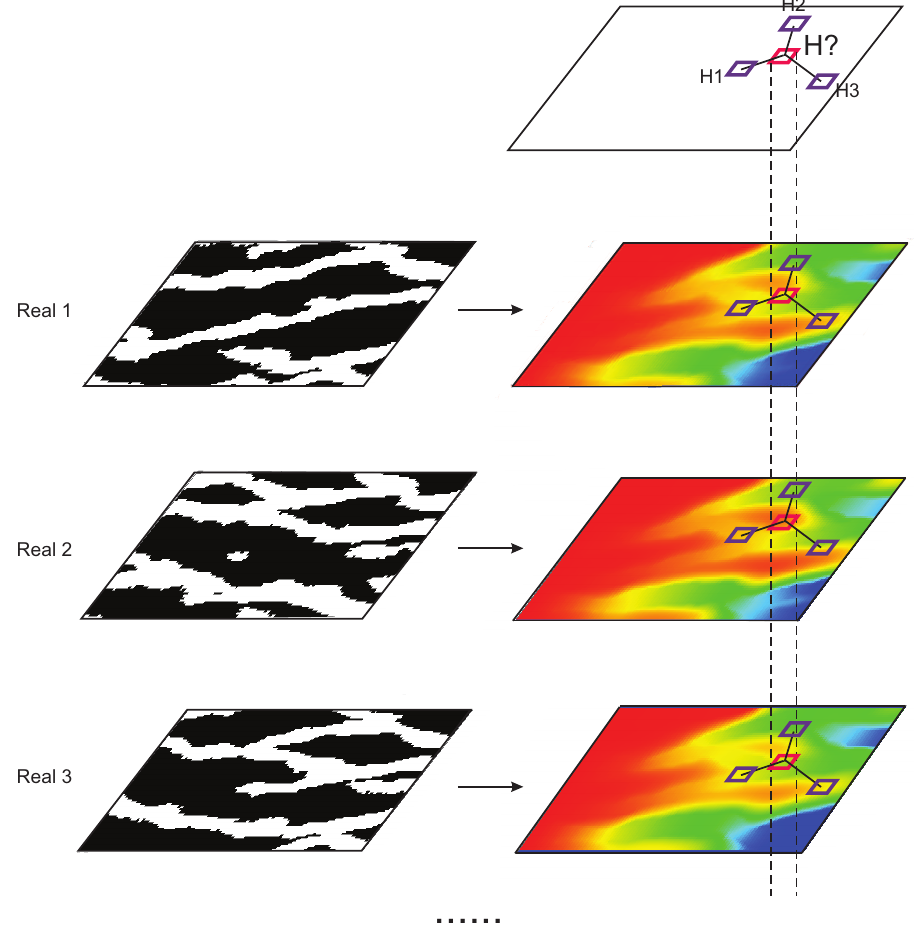
Figure 2. Scheme of pattern search using simulated groundwater level maps as ensemble training